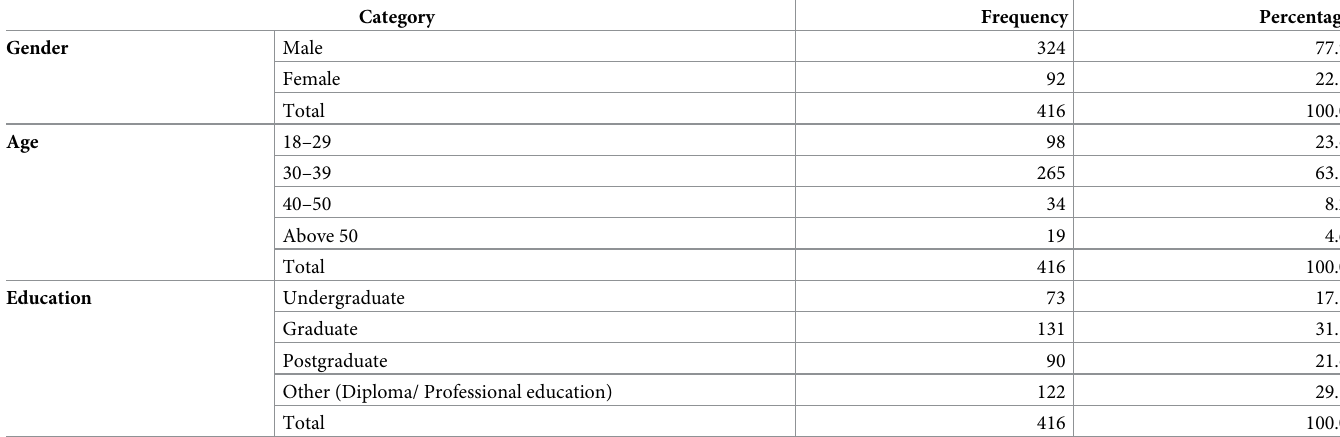
Table 1. Demographic